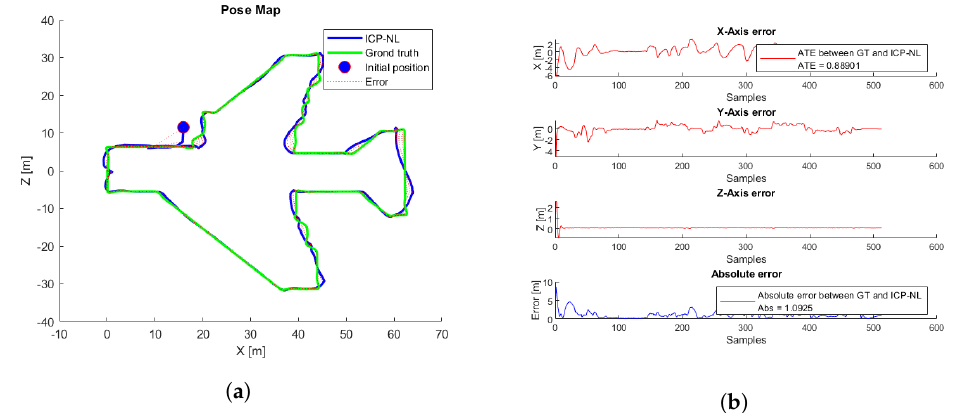
Figure 26. ICP-NL simulation test with the highest ATE. ( a ) Trajectories. ICP-NL (blue), ground truth (green), take-off position (blue circle), error (red). ( b ) ICP-N errors.